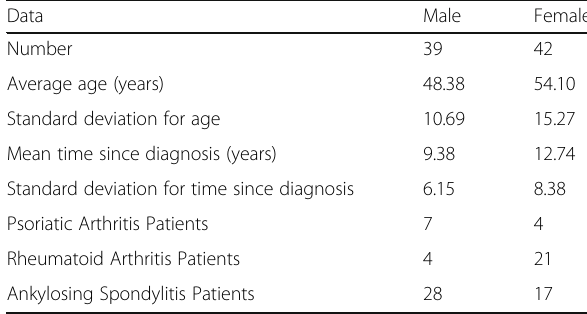
Table 1 Profile of patients in the